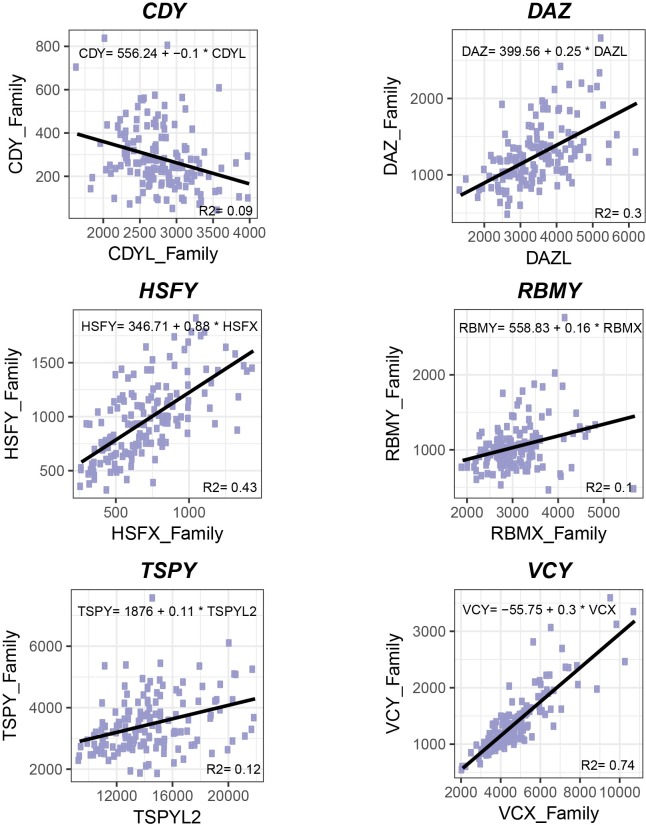
Individual-level relationship between Y ampliconic genes and their non-Y homologs.Each plot compares expression levels of Y ampliconic gene family (the sum of expression of all copies of a gene family) to their non-Y homologs in each individual (N = 149). Each dot represents an individual. The black line represents the linear regression fit to the data and the respective equation is at the top of each plot. The R-squared value is at the right-hand side bottom of each plot.